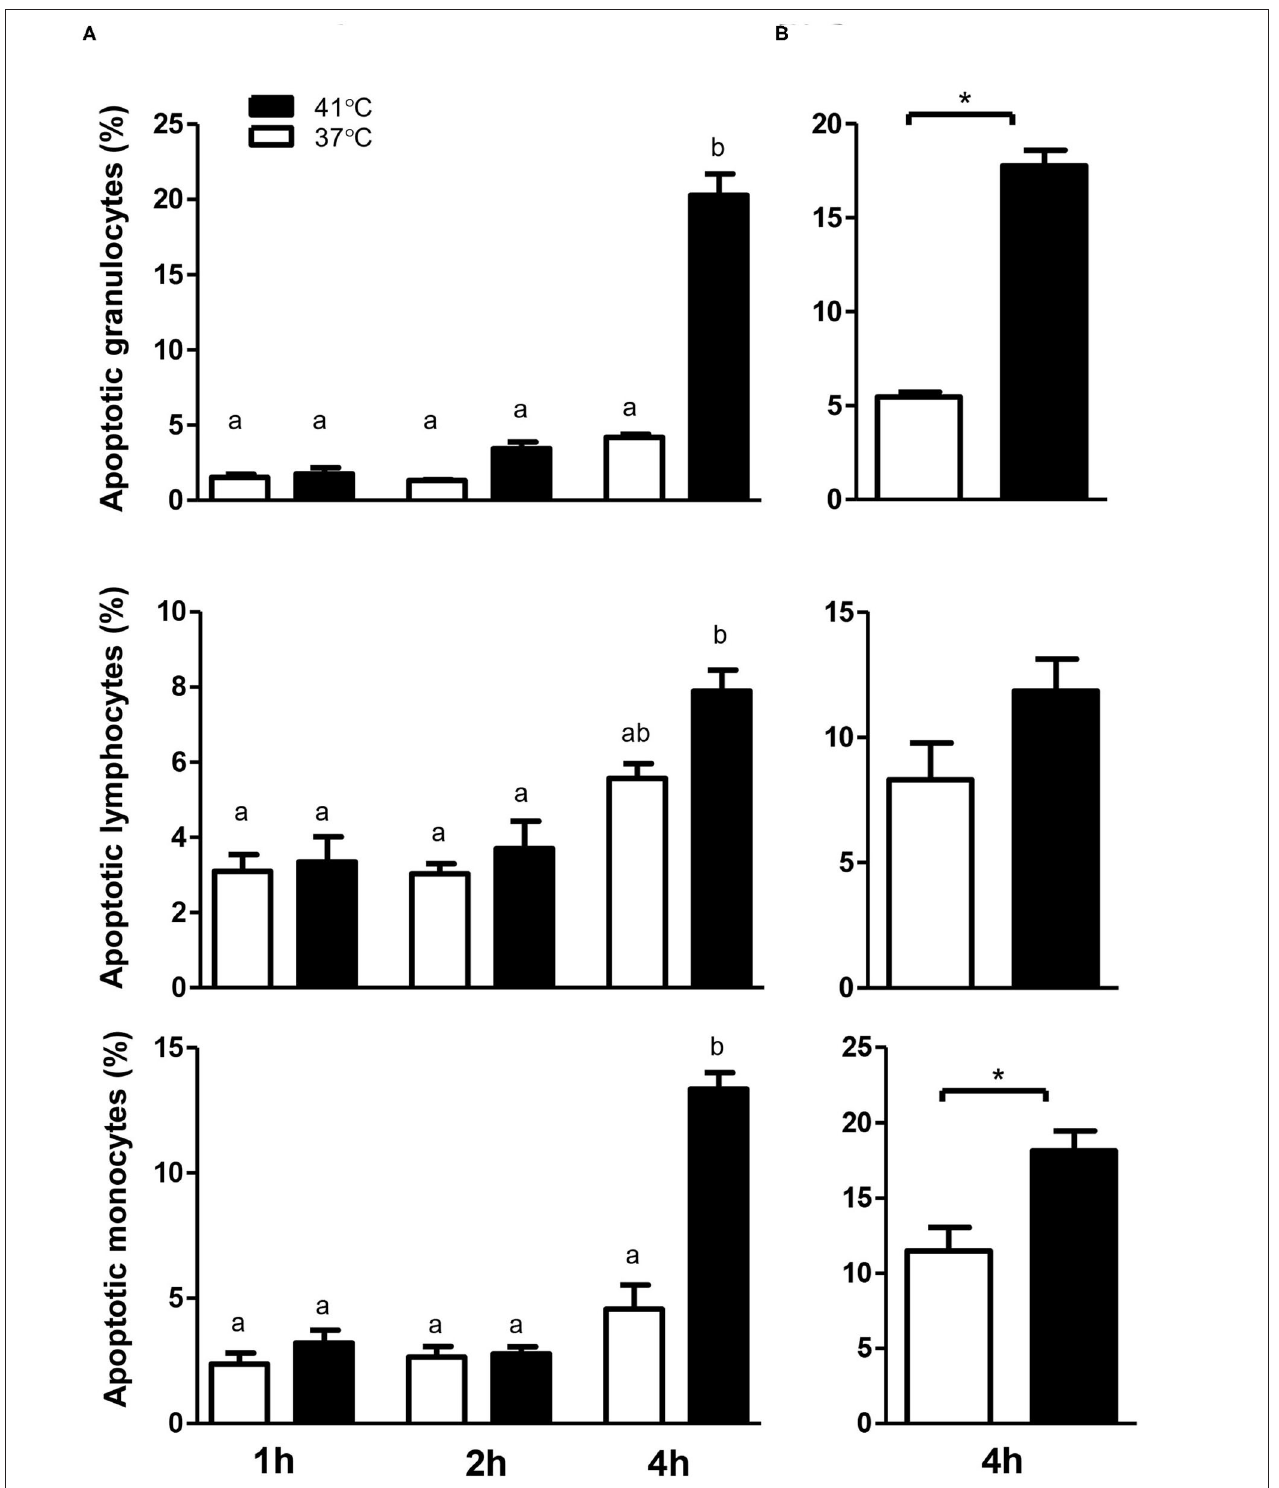
FIGURE 3 | The impact of heat stress on leukocyte cell apoptosis. Whole camel blood (A) or separated camel leukocytes (B) were incubated at 37 or 41 ◦ C for different times. The cells were loaded with the mitochondrial membrane potential (MMP) probe JC-1 and were analyzed by flow cytometry. The percentages of apoptotic cells were calculated for gated camel granulocytes, lymphocytes, and monocytes and presented as mean ± SEM. Different lower case letters indicate a significant difference between the groups as analyzed using one-way ANOVA ( p < 0.05). For separated leukocytes, the student t -test was used for comparison between the means of cells incubated at 37 and 41 ◦ C (* indicates p < 0.05).